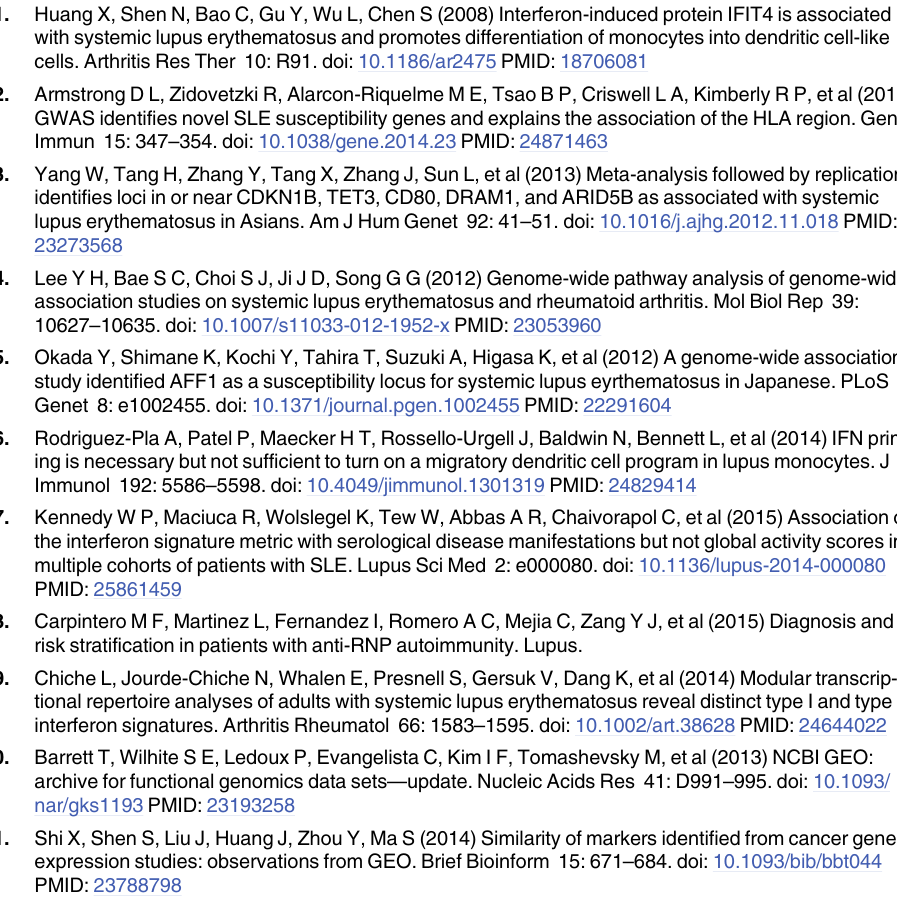
S7 Table. Interactions between the Common Marker Genes Identified in the Present Study and Known Susceptibility Genes Reported by GWAS for